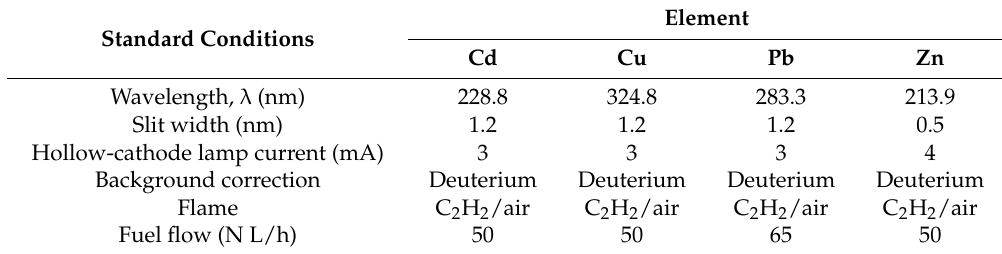
Table 4. Instrumental parameters for metal determination by flame atomic absorption spectroscopy (FAAS).